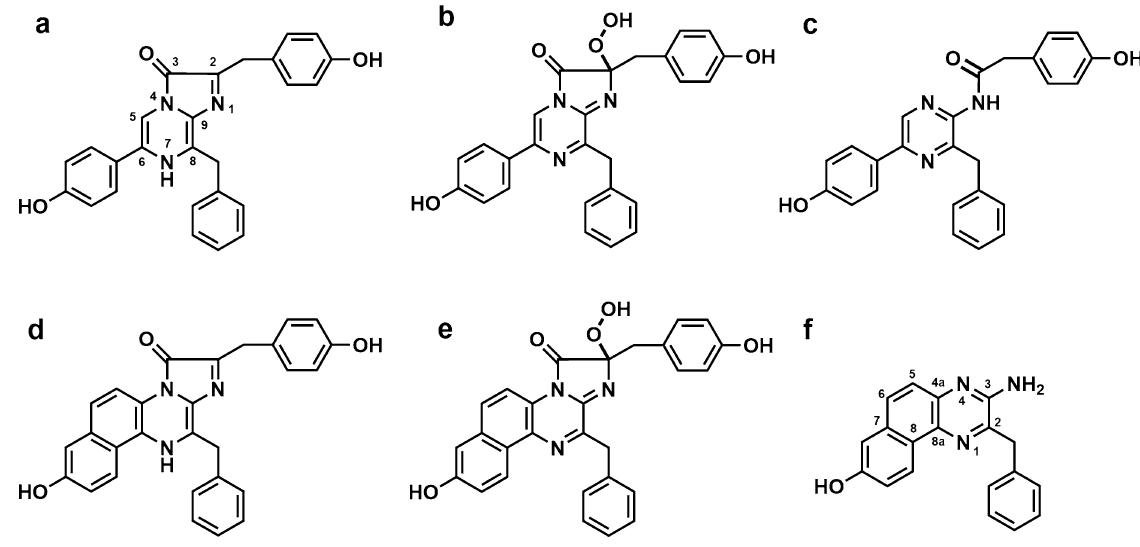
Figure 1. Coelenterazine, coelenterazine- v and their derivatives. CTZ ( a ), 2-hydroperoxyCTZ ( b ), CTD ( c ), CTZ- v ( d ), 2-hydroperoxyCTZ- v ( e ), and CTM- v ( f